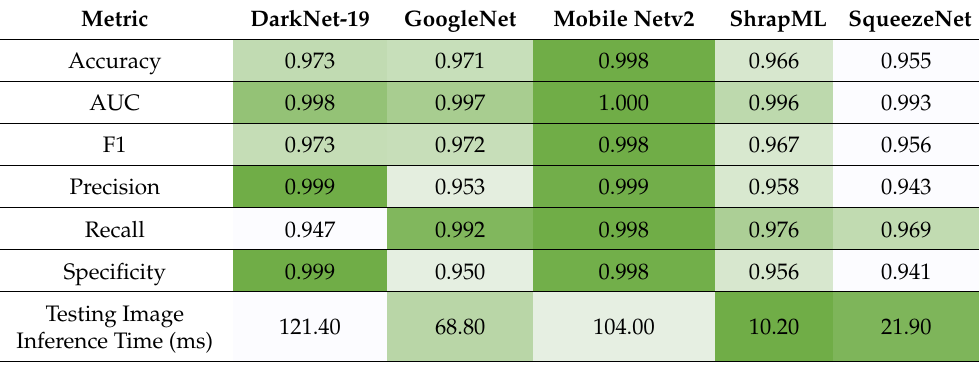
Figure 4. Confusion matrix analysis after 100 training epochs for ( A ) DarkNet-19, ( B ) GoogleNet, ( C ) MobileNetv2, ( D ) ShrapML, and ( E ) SqueezeNet. Table 6. Summary of performance metrics for each of five models trained using 100 epochs. The single-color heat map indicates the best-performing models in green, with worst being uncolored for each performance metric